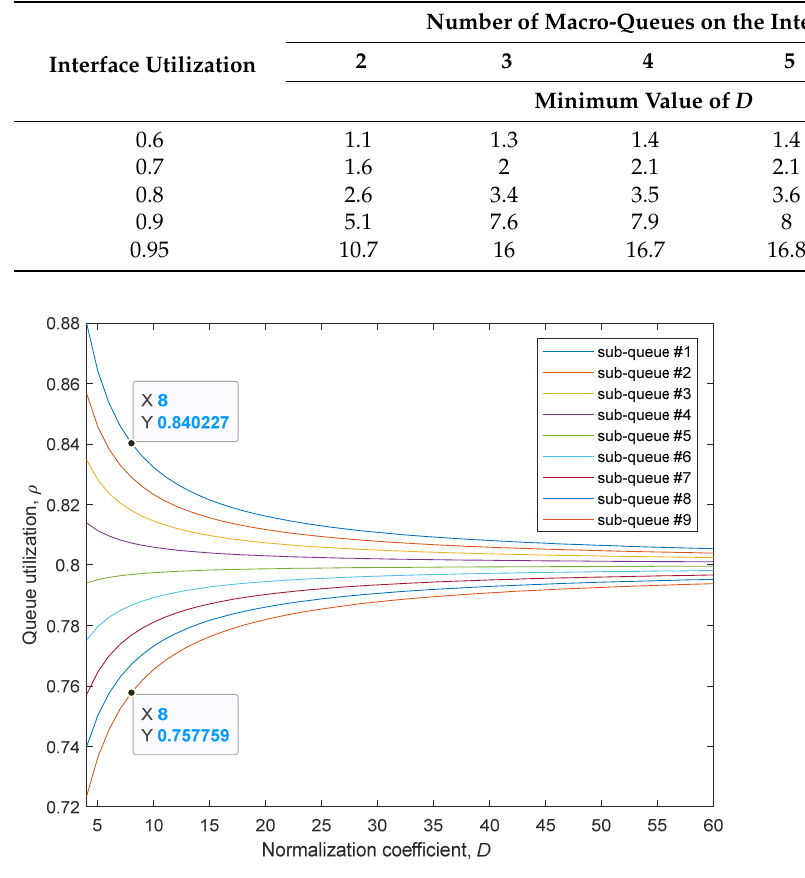
Figure 3. Dependence of queue utilization for nine priority sub-queues on normalization coefficient D .